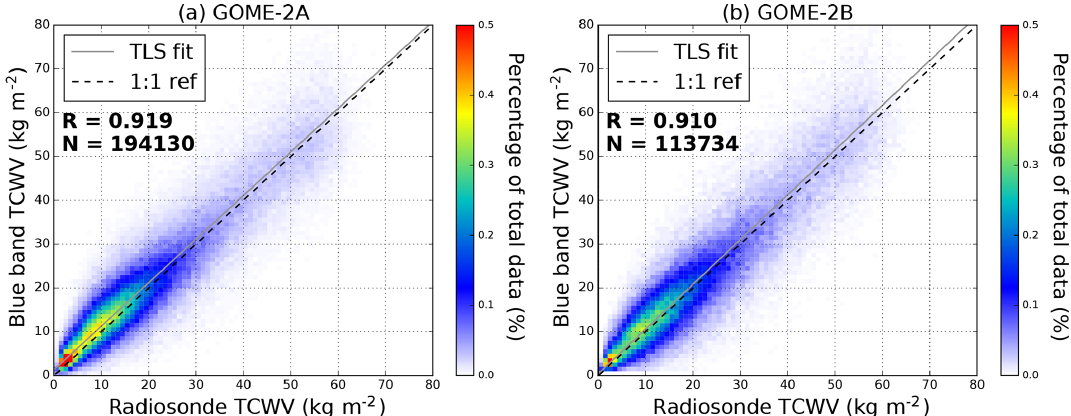
Figure 14. Comparison of radiosonde measurements of TCWV to GOME-2A is shown in (a) , while the comparison to GOME-2B observa- tions is shown in (b) . Co-located data are used in the comparison.